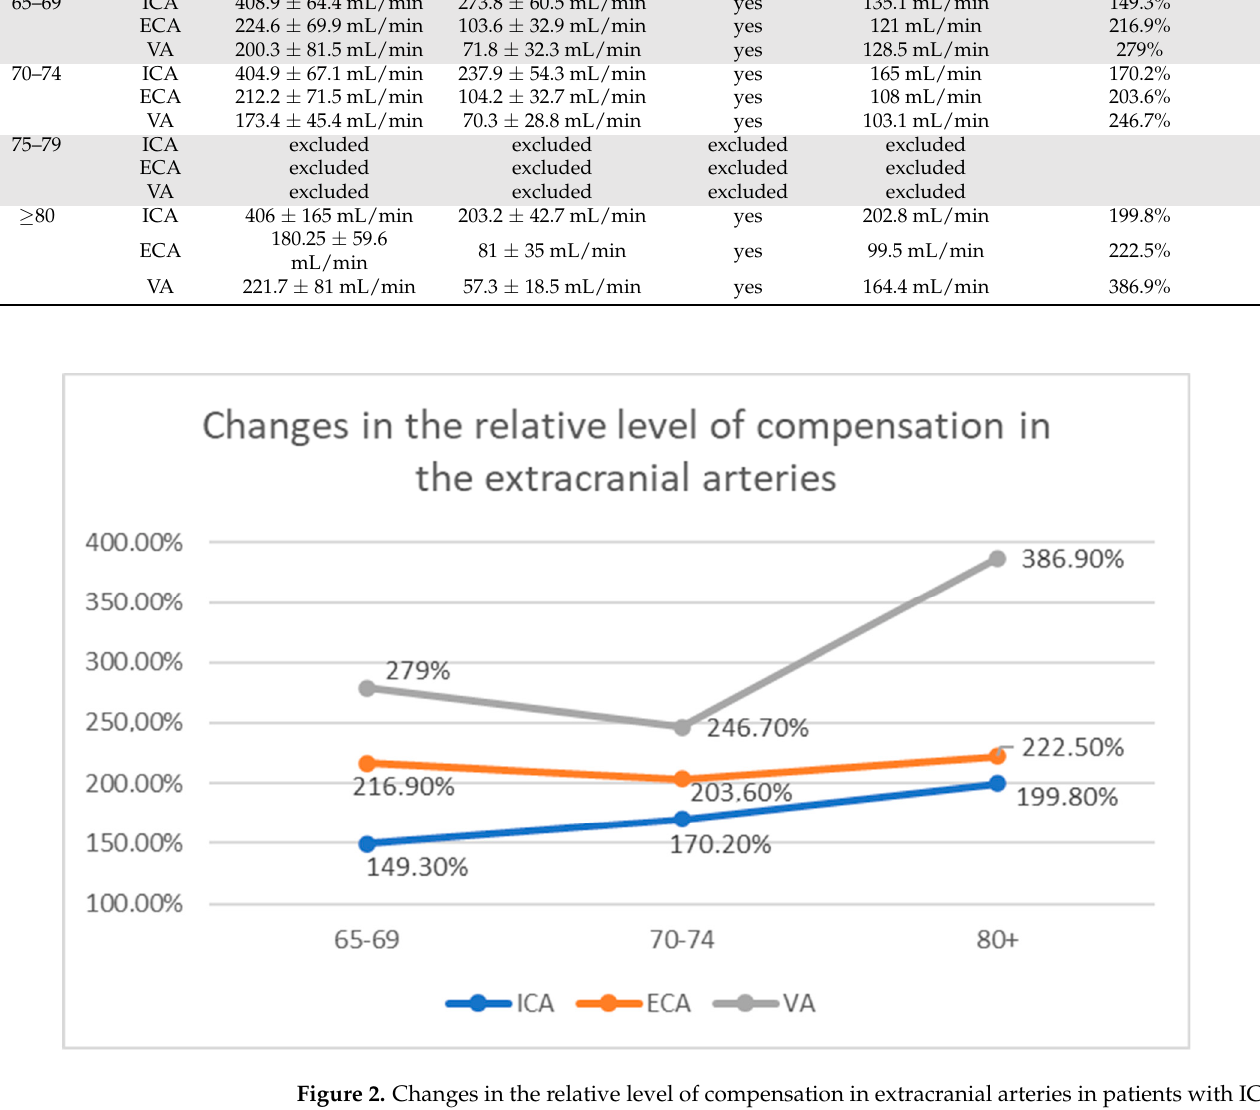
Table 4. The level of compensation in all extracranial arteries.